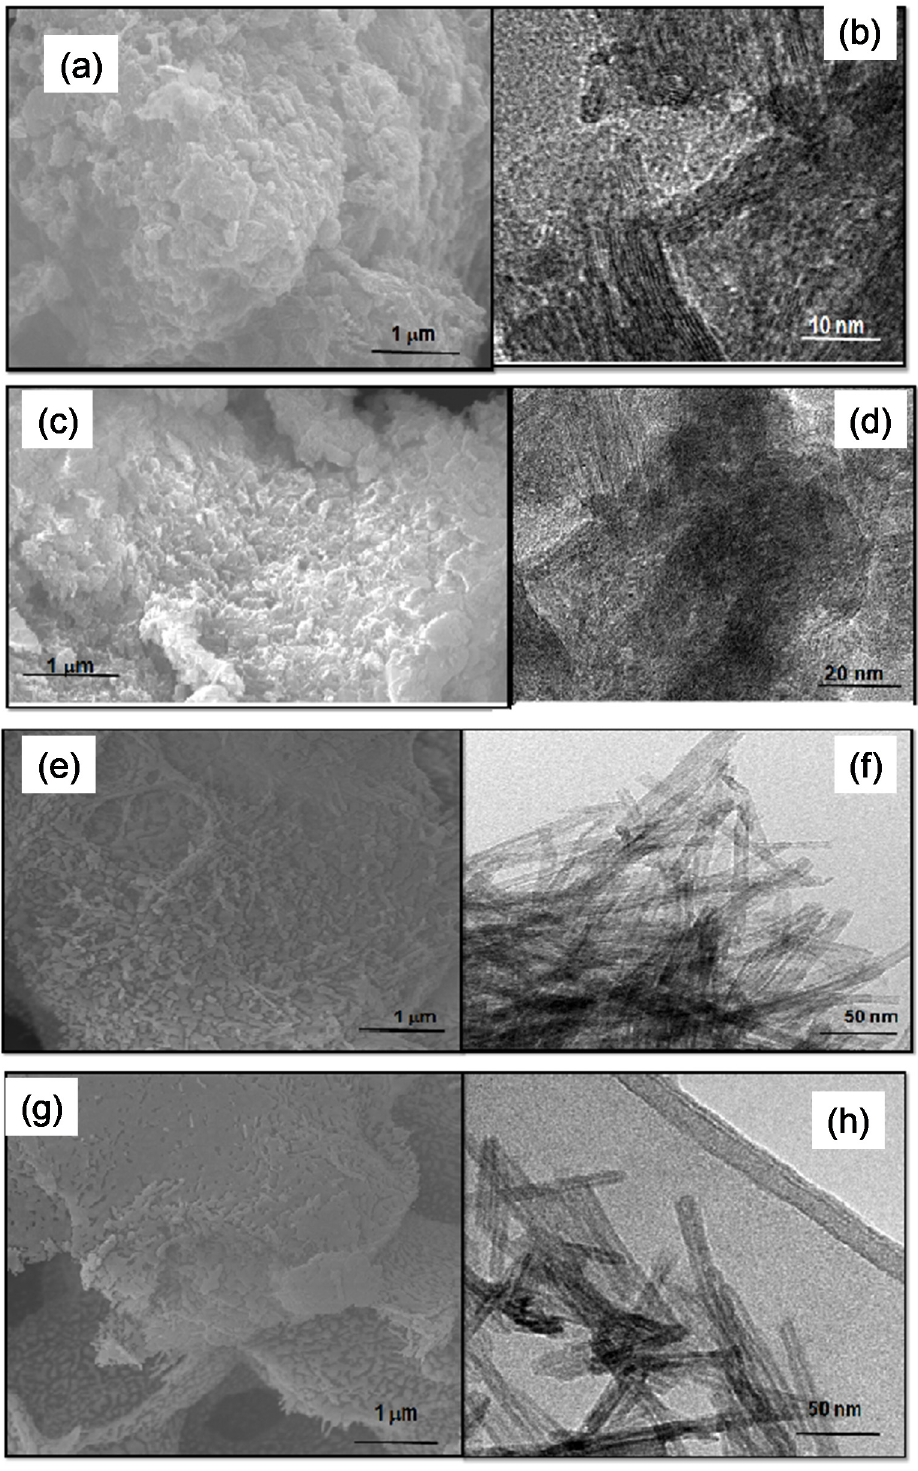
Figure 3. SEM-EDS and TEM micrographs of the catalysts studied: ( a , b ) AlNT, ( c , d ) AgNT, ( e , f ) NiNT and ( g , h ) PtNT. The included Figure in TEM image of PtNT is related to the Pt nanoparti- cles.